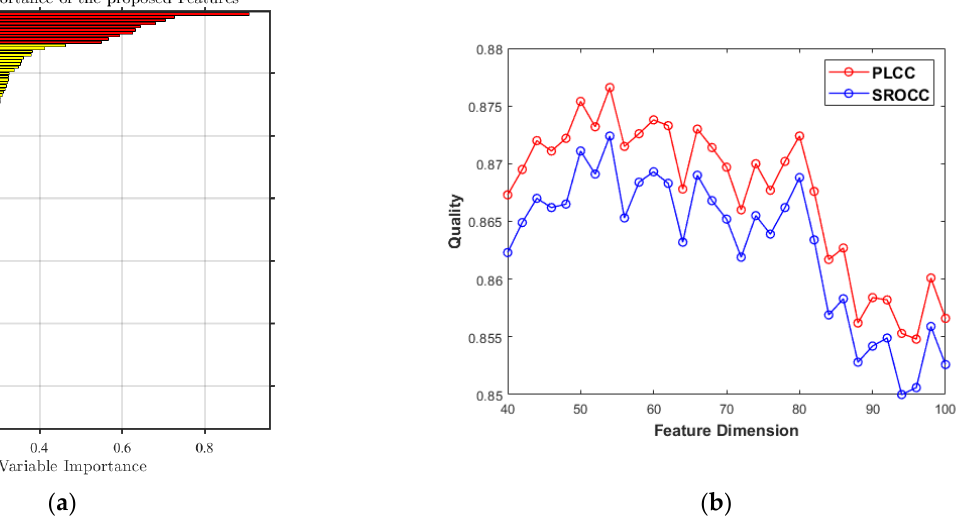
Figure 10. Feature screening. ( a ) Descending arrangement of contribution values of all features. ( b ) Performance of feature vector with different dimensions.